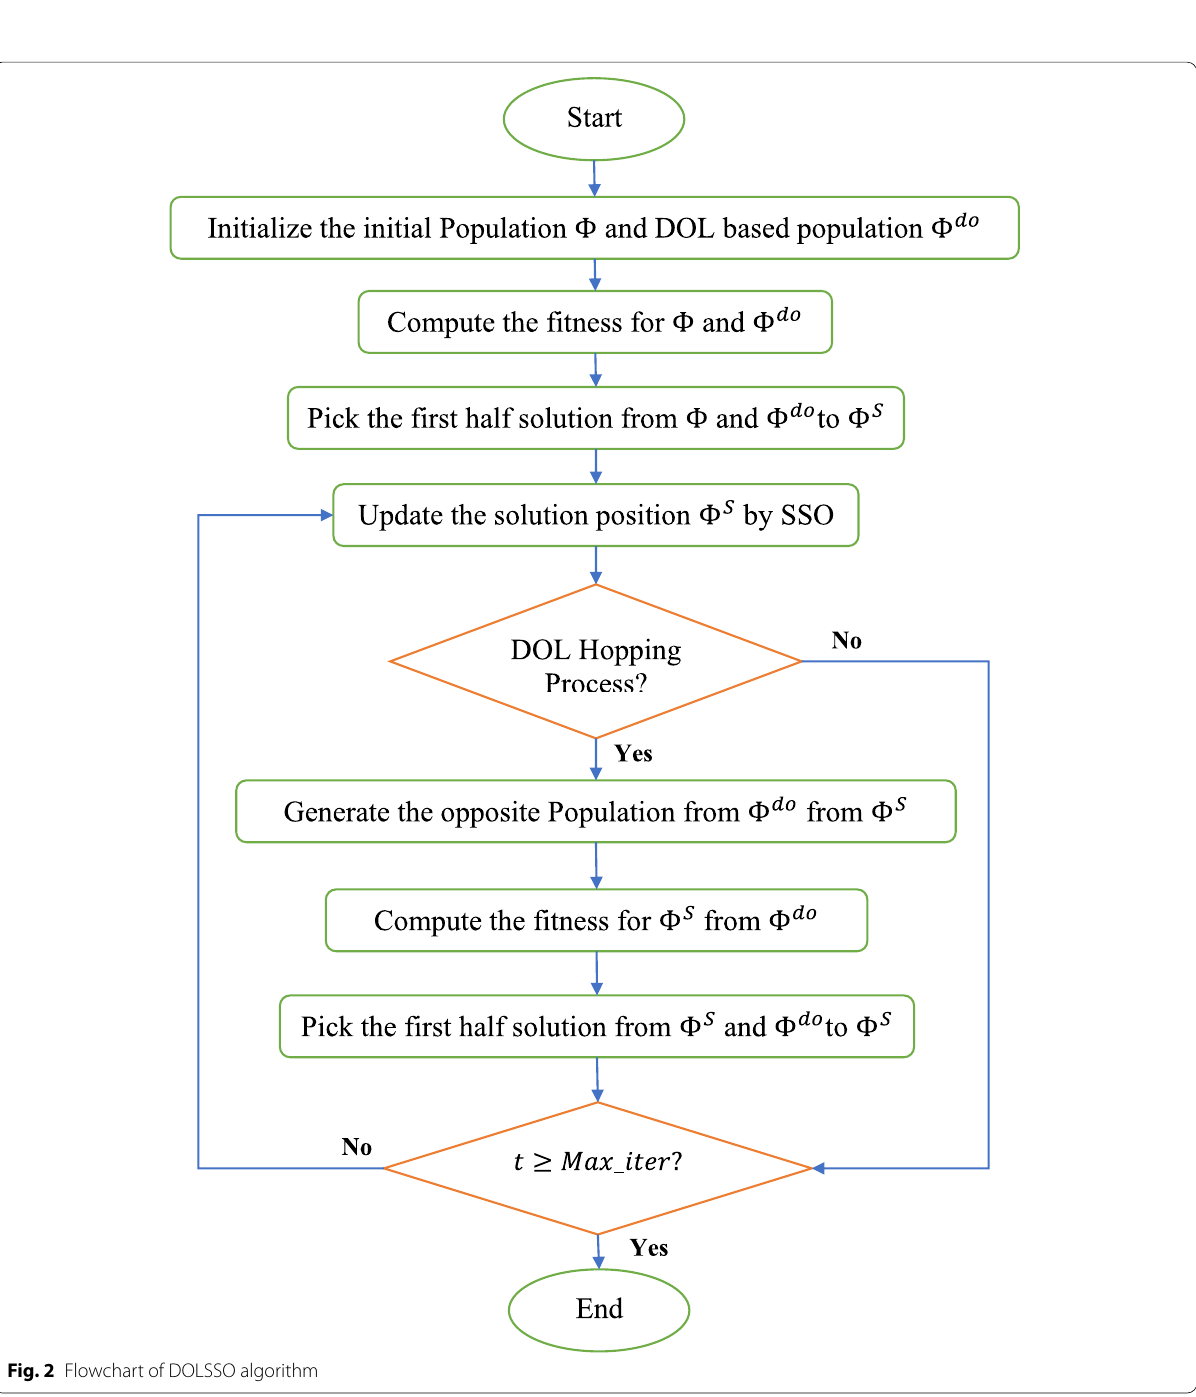
Fig. 2 Flowchart of DOLSSO